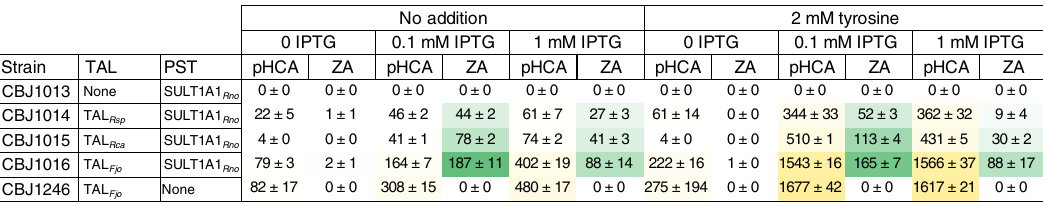
Fig. 3 Production of zosteric acid directly from glucose in minimal medium in recombinant E. coli . Selected strains expressing SULT1A1 Rno in combination with either no tyrosine ammonia-lyase (TAL) or one of the tyrosine ammonia-lyases from Rhodobacter sphaeroides (TAL Rsp ), Rhodobacter capsulatus (TAL Rca ), or Flavobacterium johnsoniae (TAL Fjo ), respectively, were grown in M9 medium with 0.2% glucose for 24 h. Resulting production titers ( µ M) of p -coumaric acid (pHCA) or zosteric acid (ZA) and standard deviations (± for n = 3) are shown. Source data are provided as a Source Data acid were reached in the strain combining SULT1A1 Rno with TAL Fjo — both under induction with 0.1 mM ITPG and 1 mM IPTG. The growth was signi fi cantly in fl uenced by the induction with IPTG; and while it mainly affected the growth rate at 0.1 mM IPTG, it increased the lag phase at 1 mM (Supplementary Fig. 5).